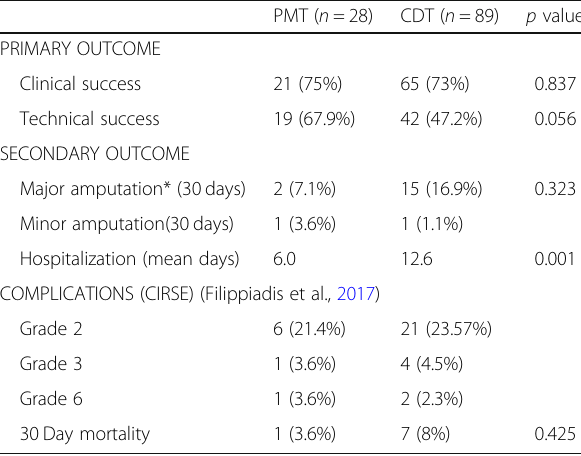
Table 1 Population characteristics